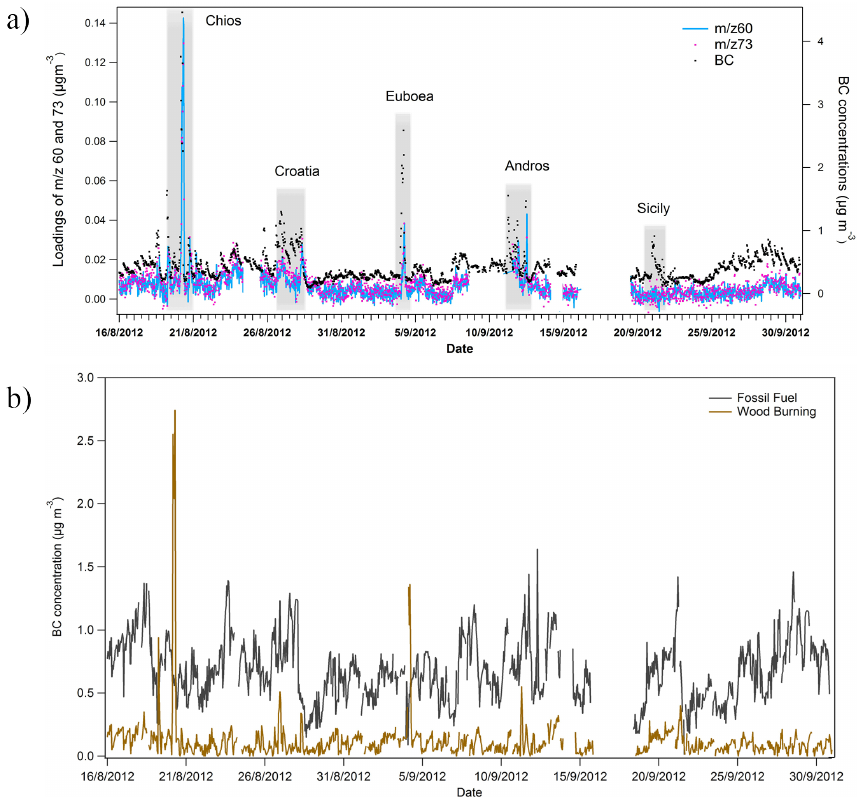
Fig. 3. (a) The time series of the biomass tracer loadings of m/z 60, m/z 73 and black carbon; the shaded areas represent the identified fire events and locations. (b) Estimated source apportionment of BC concentrations based on light-absorption